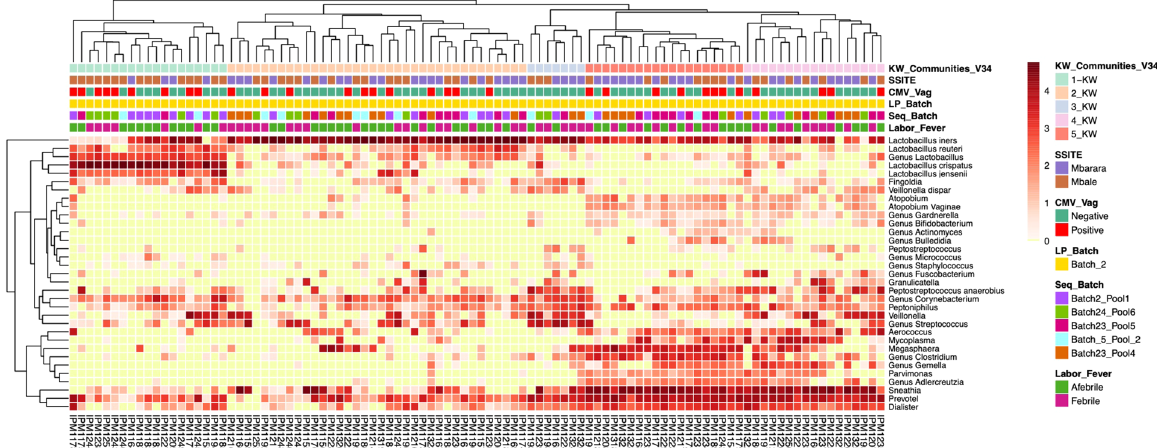
Fig. 2 Vaginal bacterial community characterization heatmaps of intrapartum Ugandan women through hierarchical clustering. Vaginal bacterial community classi fi cation through selected bacteria after Kruskal – Wallis (KW) test. KW_Communities_V34 are the communities identi fi ed by bacteria selected from the KW test. Color of the heatmap represents log10 normalized counts of species and yellow represents zero counts. Annotations are as follows: KW_Communities_V34 is the vaginal community identi fi ed from V3 – V4 regions through hierarchical clustering followed by bacteria selected by KW test. CMV_Vag represents CMV status of the vaginal samples identi fi ed by PCR; LP_Batch is the library preparation batch; Seq_Batch is the sequencing batch, which the samples were processed in; Labor_Fever is the fever status of the laboring woman (see “ Methods ” for de fi nitions; SSITE is the sample collection site (Mbarara or